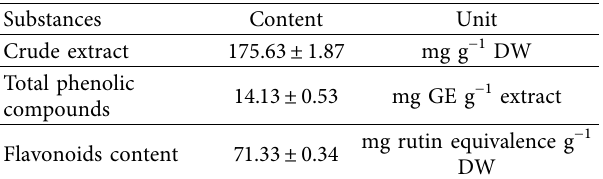
Table 1: The amount of constituent compounds of G. biloba tea extract (mean ± SD, n �